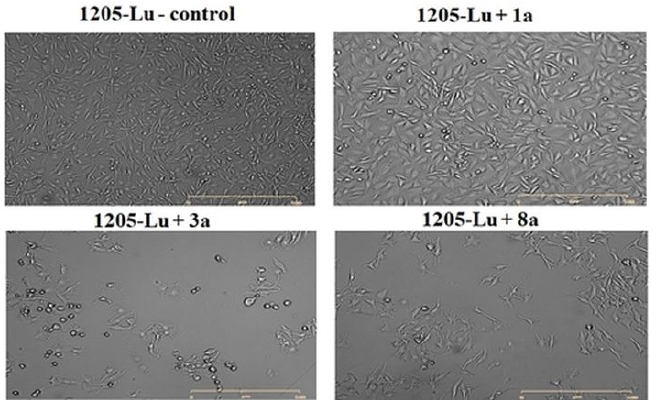
Figure 1. The influence of free phenolic acid (1a) and its conjugates on the studied cell lines. Repre- sentative profiles of growth inhibition exerted by free ANISA and the most active ANISA-conjugates in 451-Lu and Me45 ( A ), as well as in 1205-Lu and NHDF cells ( B ). Representative images of Me45 and 1205-Lu melanoma cells in the presence of ANISA and its derivatives at 100 μ M ( C ).